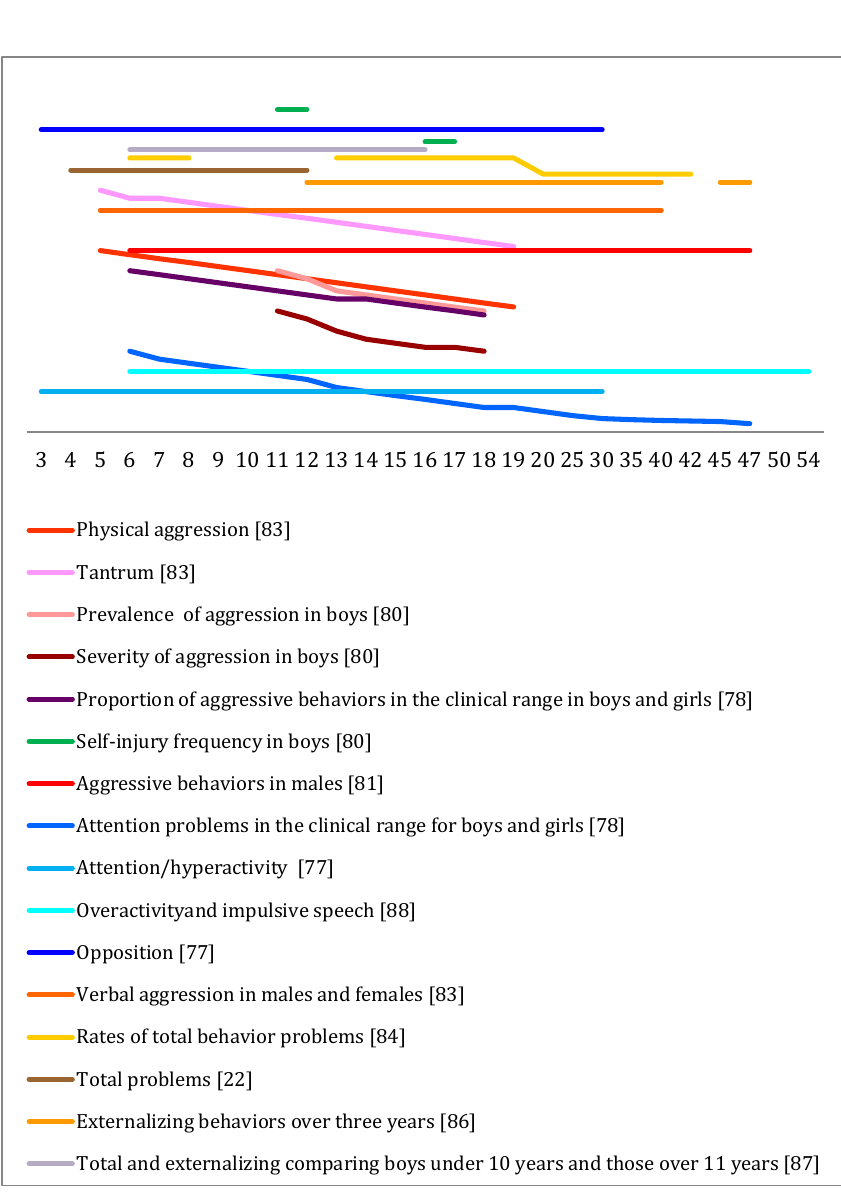
Figure A1. Trajectories of behavior problems over the years reported by the studies reviewed. This graph provides descriptive information of the trajectories reported in the studies review- ed [22,77,78,80,81,83,84,86–88]. The Y-axis has been removed because of the use of different measures and comparisons not being possible. Higher or lower lines do not represent greater problem behav- iors or a higher frequency of behavior problems, nor does the slope. Each line should be compared with itself. For example, in this graph, tantrum scores compared with physical aggression are not higher, nor do they decrease faster over the years. One finding from the graph is that tantrum scores decreased from 5 to 19 years in